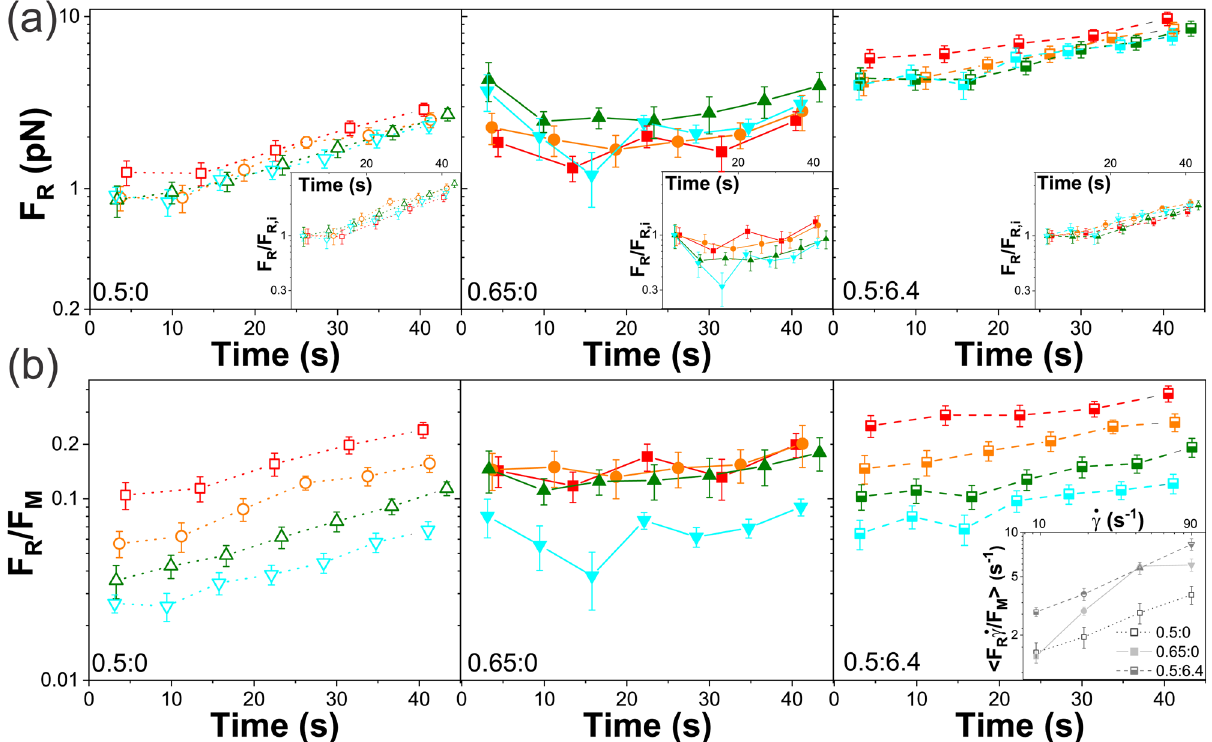
Fig. 7 | Residual force following cessation is _ γ -independent with distinct time dependence for the 0.65:0 blend. a Residual force F R maintained at the end of each Δ t R = 3scessationperiodversusmeasurementtimeduringrepeatedstraining (seeFig.1)at _ γ = 9.4s − 1 (red),19s − 1 (orange),42s − 1 (olive),and90s − 1 (cyan)for0.5:0 (left, open symbols), 0.65:0 (middle, fi lled symbols), and 0.5:6.4 (right, half- fi lled symbols).Insets show F R normalized bythe corresponding initialvalue F R , i : b Data shown in a , normalized by the corresponding maximum force F M , shows that the fractional residual force, an indicator of elastic storage, increases with time and _ γ